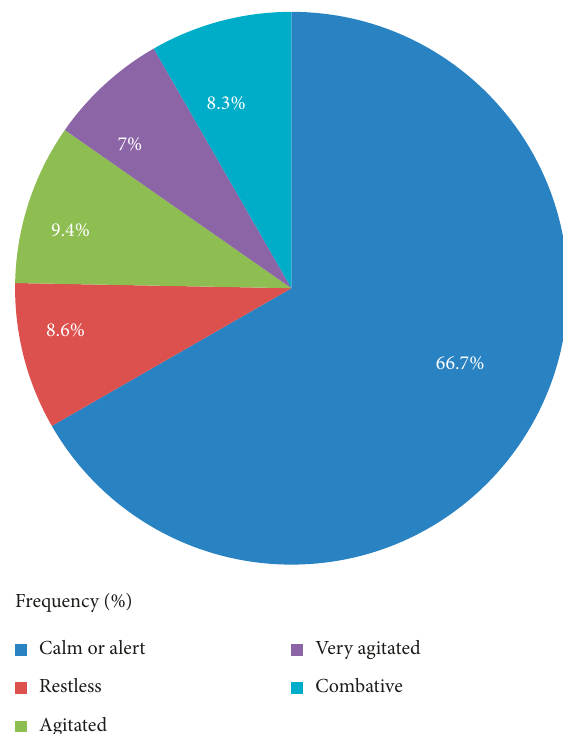
Figure 2: The frequency of sedation score in older patients who underwent elective surgery in the Teaching Hospitals of